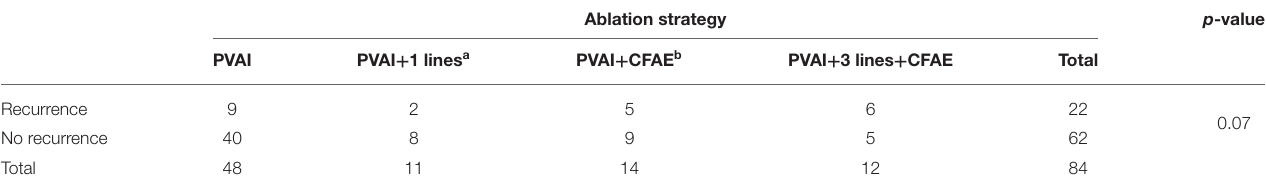
TABLE 5 | The relation between ablation strategy and AF recurrence.